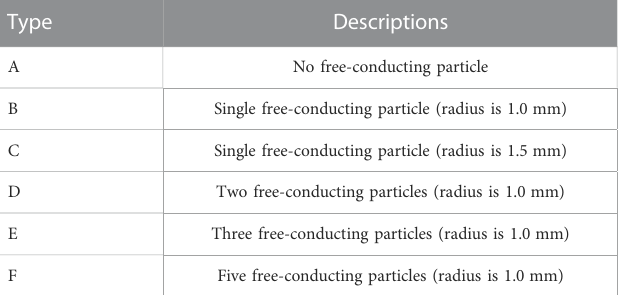
TABLE 1 Descriptions of six working